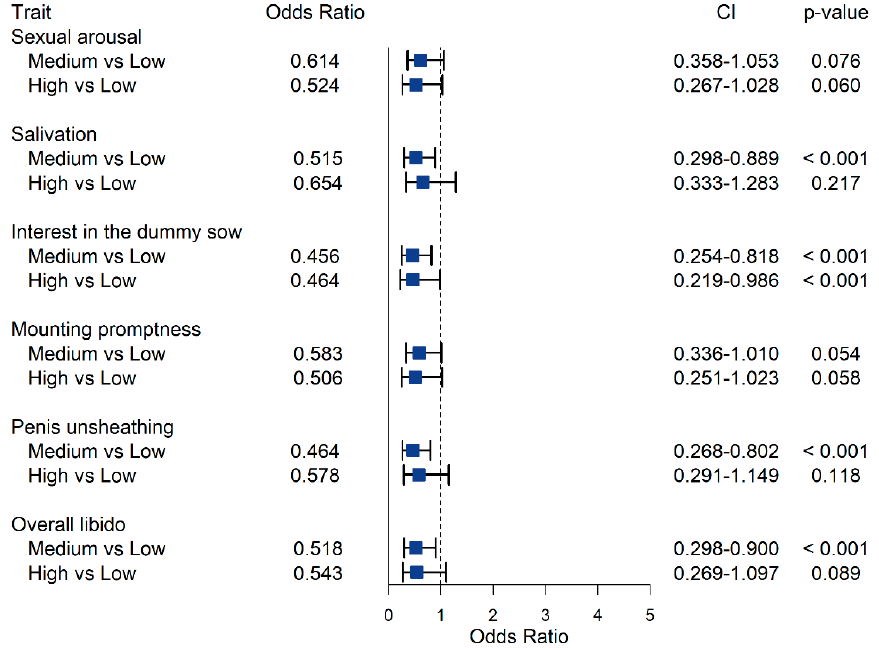
Figure 4. Odds ratio for the effect of average and high skatole concentration in subcutaneous adi- pose tissue, compared to low skatole concentration, on sexual behavior traits evaluated during the third training session. The dashed line corresponds to an odds ratio equal to 1.00.